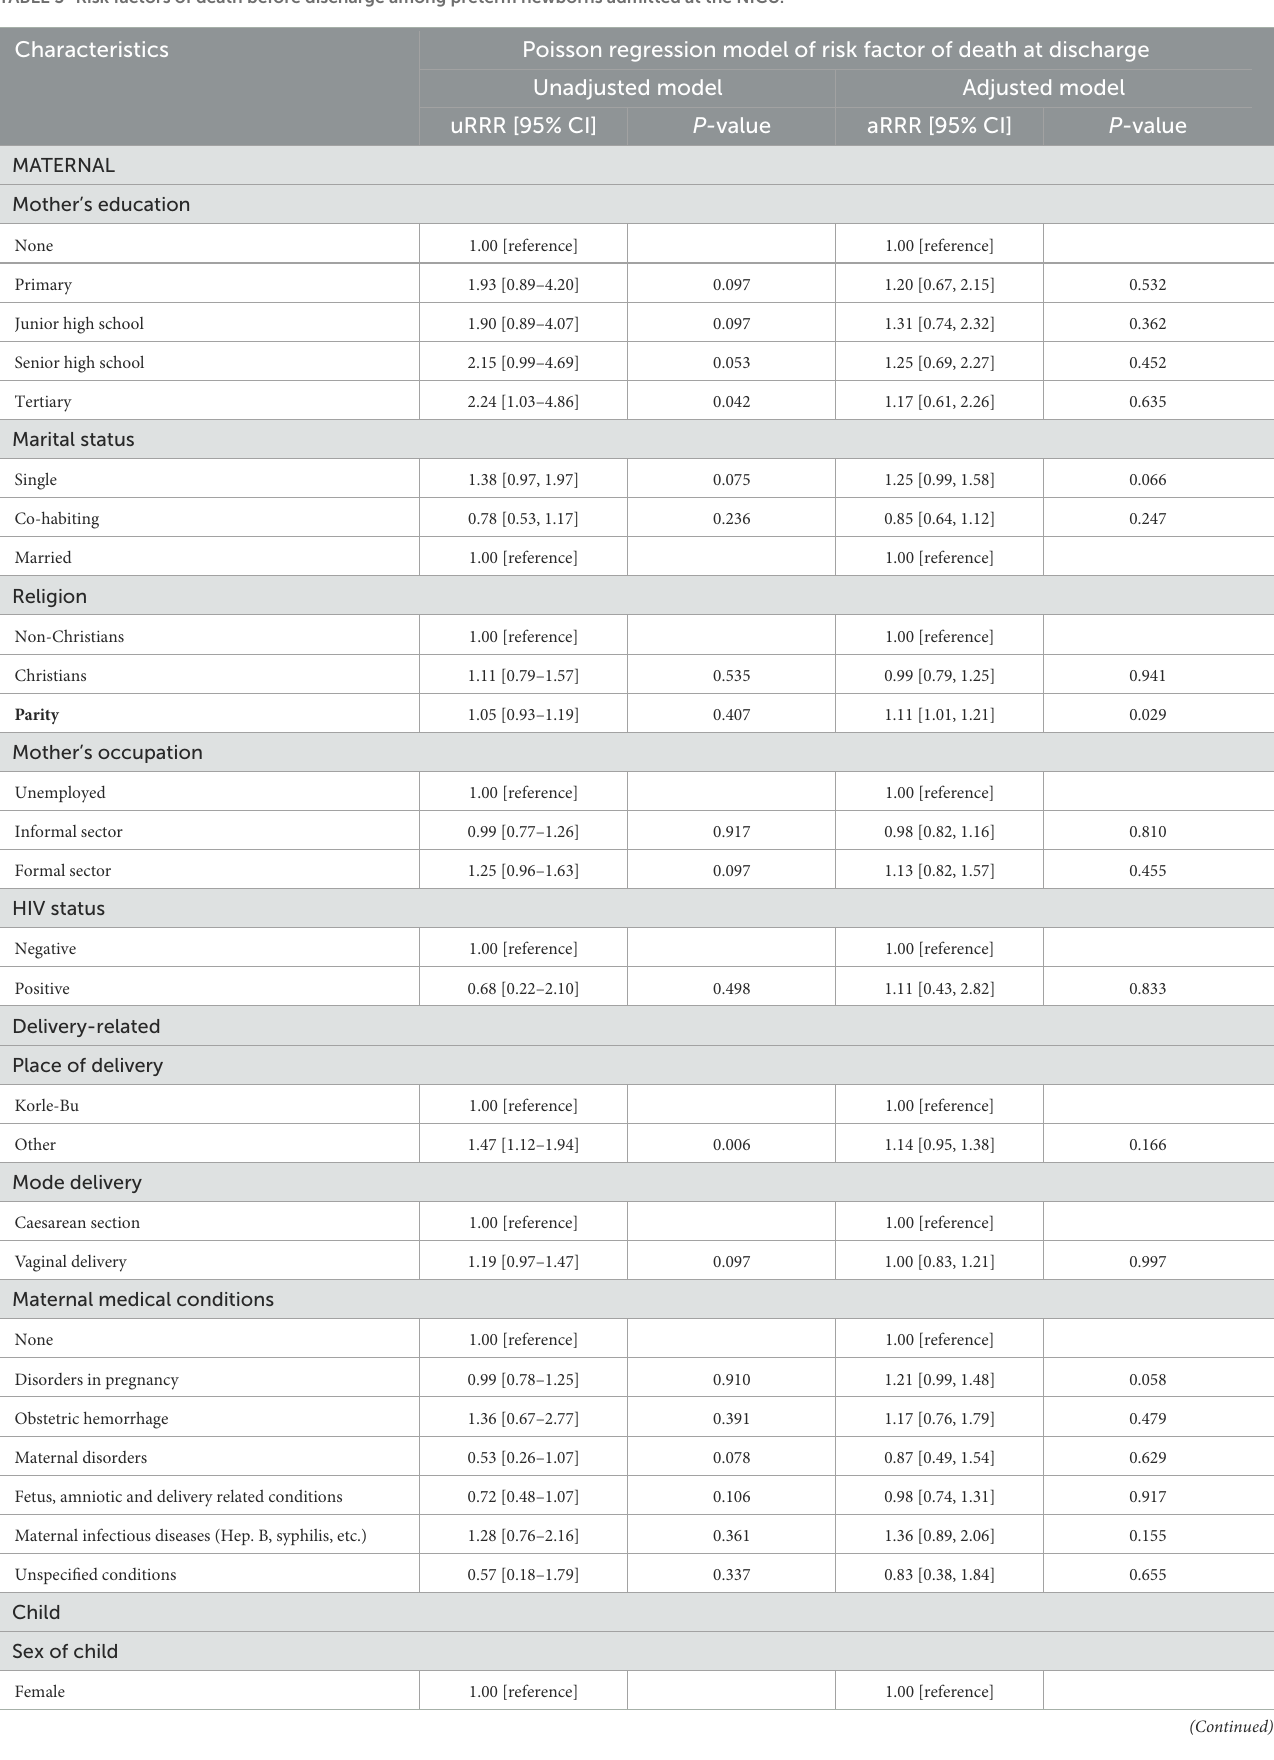
TABLE 3 Risk factors of death before discharge among preterm newborns admitted at the NICU.